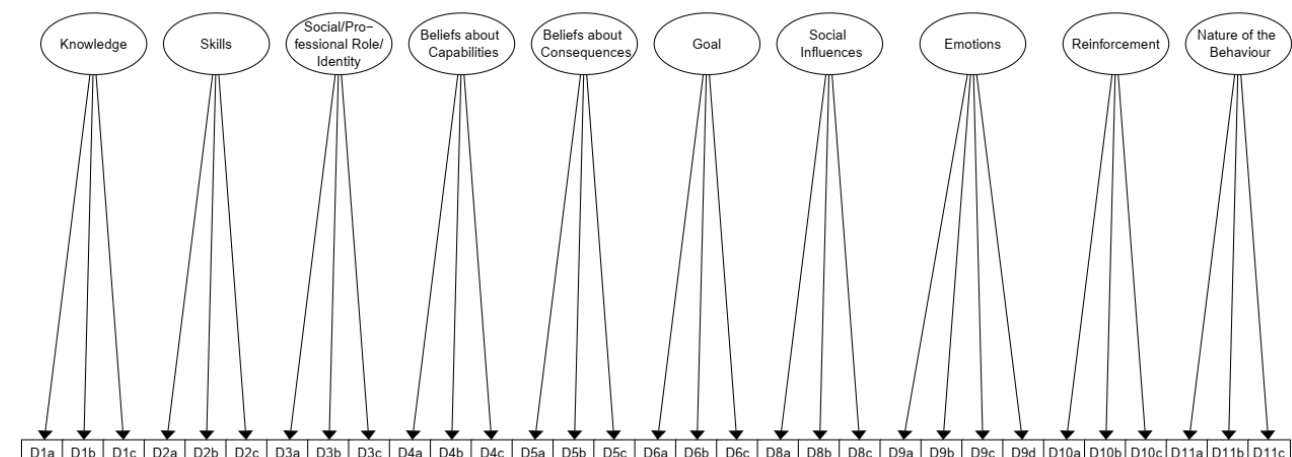
Figure 2. Path diagram of the CFA of the CIBQ. CFA = Confirmatory Factor Analysis; CIBQ = Com- munity Implementation Behaviour. Circular nodes represent the latent variables (domains) whereas square nodes represent the manifest variables (items). The arrow represents a directed effect between a latent and a manifest variable.